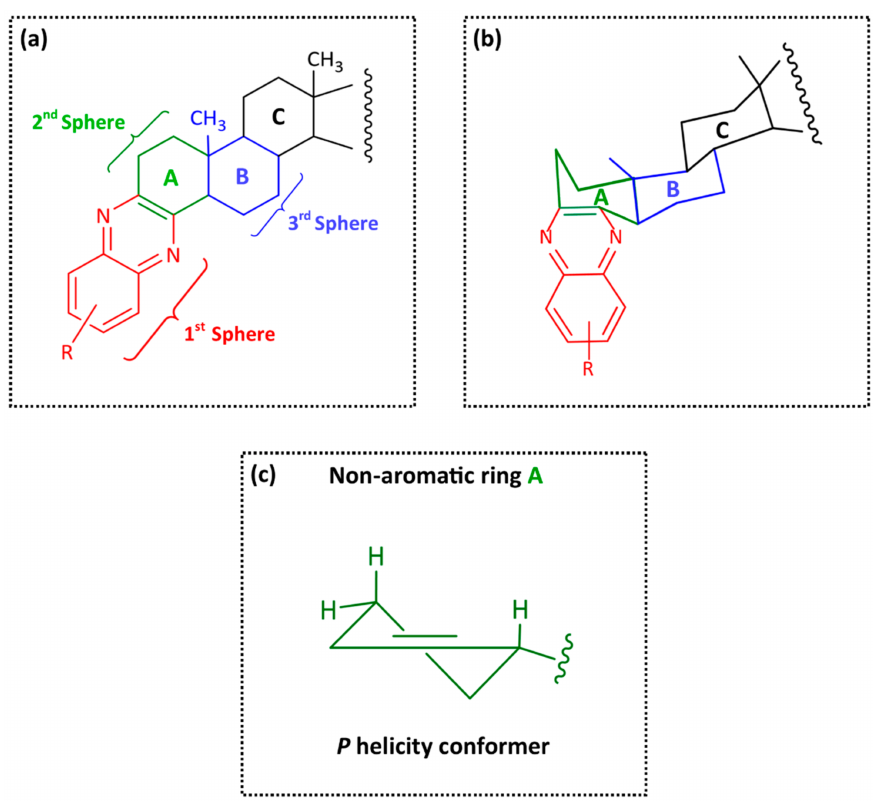
Figure 5. Chiral representation of steroidal quinoxalines: ( a ) Classification of steroidal quinoxa- lines into spheres for determining the helicity, ( b ) Stereo conformation of steroidal quinoxalines, ( c ) Quadrant rule applications to analyze CD